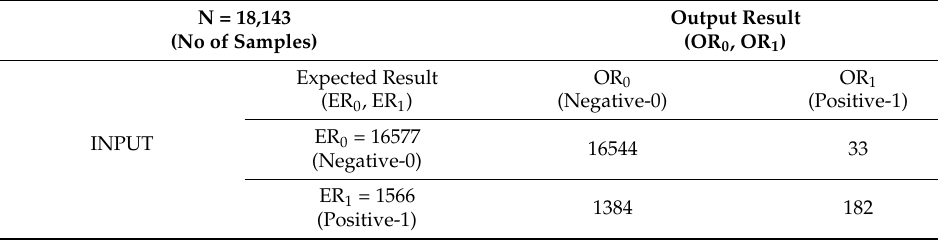
Table 10. SVM training results.